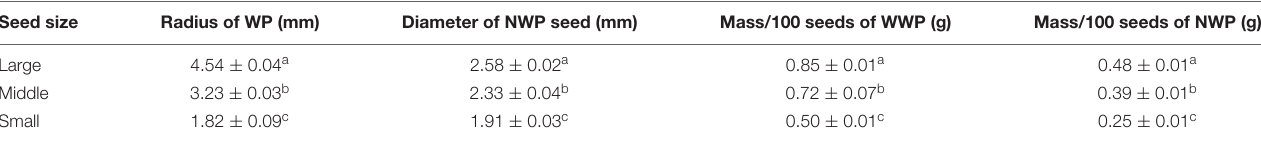
FIGURE 2 | Morphology of heteromorphic seeds of S. ferganica . (A–F) Intact dry seeds. (A) Large seed with winged perianth (WP). (B) Middle seed with WP. (C) Small seed with WP. (D) Large seed without WP. (E) Middle seed without WP. (F) Small seed without WP. (G–J) Germination process of spiral embryo of seed without WP. Scale bars: (A–J) : 1 mm. TABLE 2 | The characteristics of heteromorphic seeds of S.